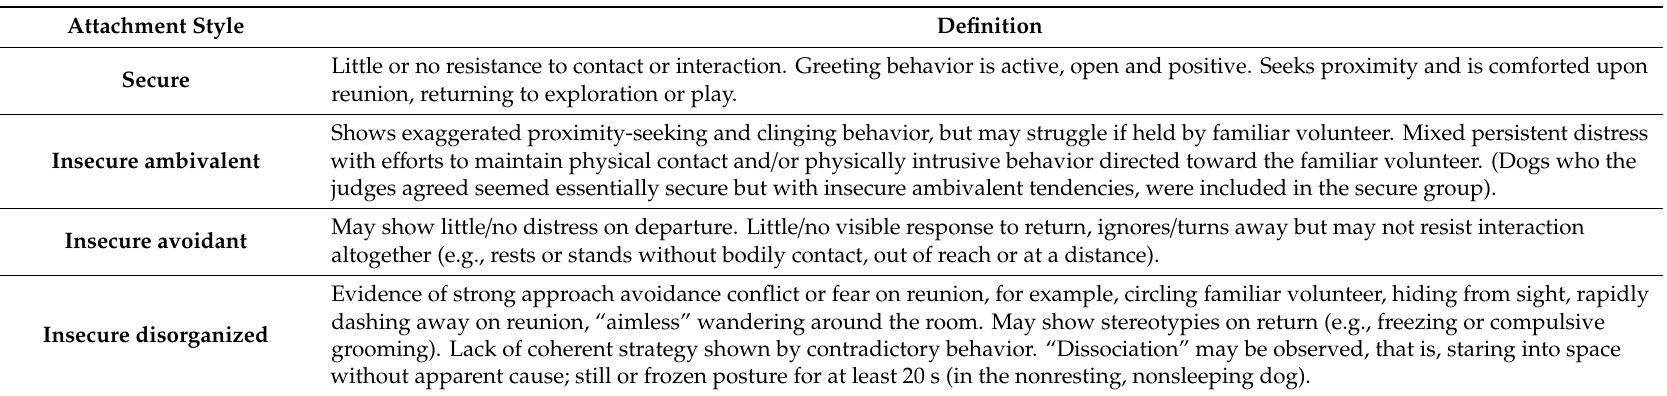
Table 1. Holistic coding attachment style definitions (adapted from